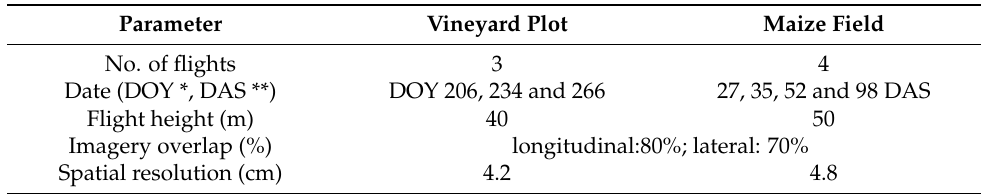
Table 1. Flight parameters, dates, and the number of the flight campaigns carried out in the vineyard plot and in the maize field. DOY: day of the year; DAS: day of sowing. Parameter Vineyard Plot Maize Field No. of flights 3 4 Date (DOY *, DAS **) DOY 206, 234 and 266 27, 35, 52 and 98 DAS Flight height (m) 40 50 Imagery overlap (%) longitudinal:80%; lateral: 70% Spatial resolution (cm) 4.2 4.8 * DOY: day of the year; ** DAS: days after sowing.